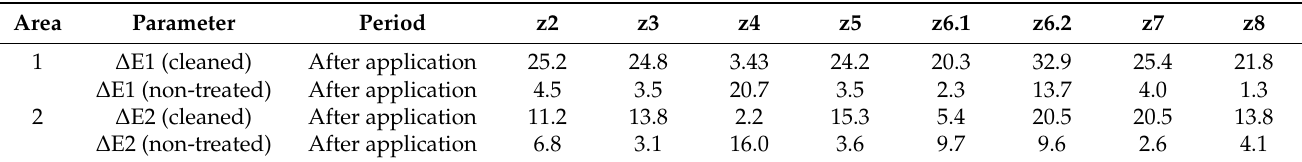
Table 7. Colorimetric parameter ∆ E* of each zone of Area 1 and Area 2 calculated as referred to the treated surface and to the non-treated. Standard deviation 0.5 < SD <